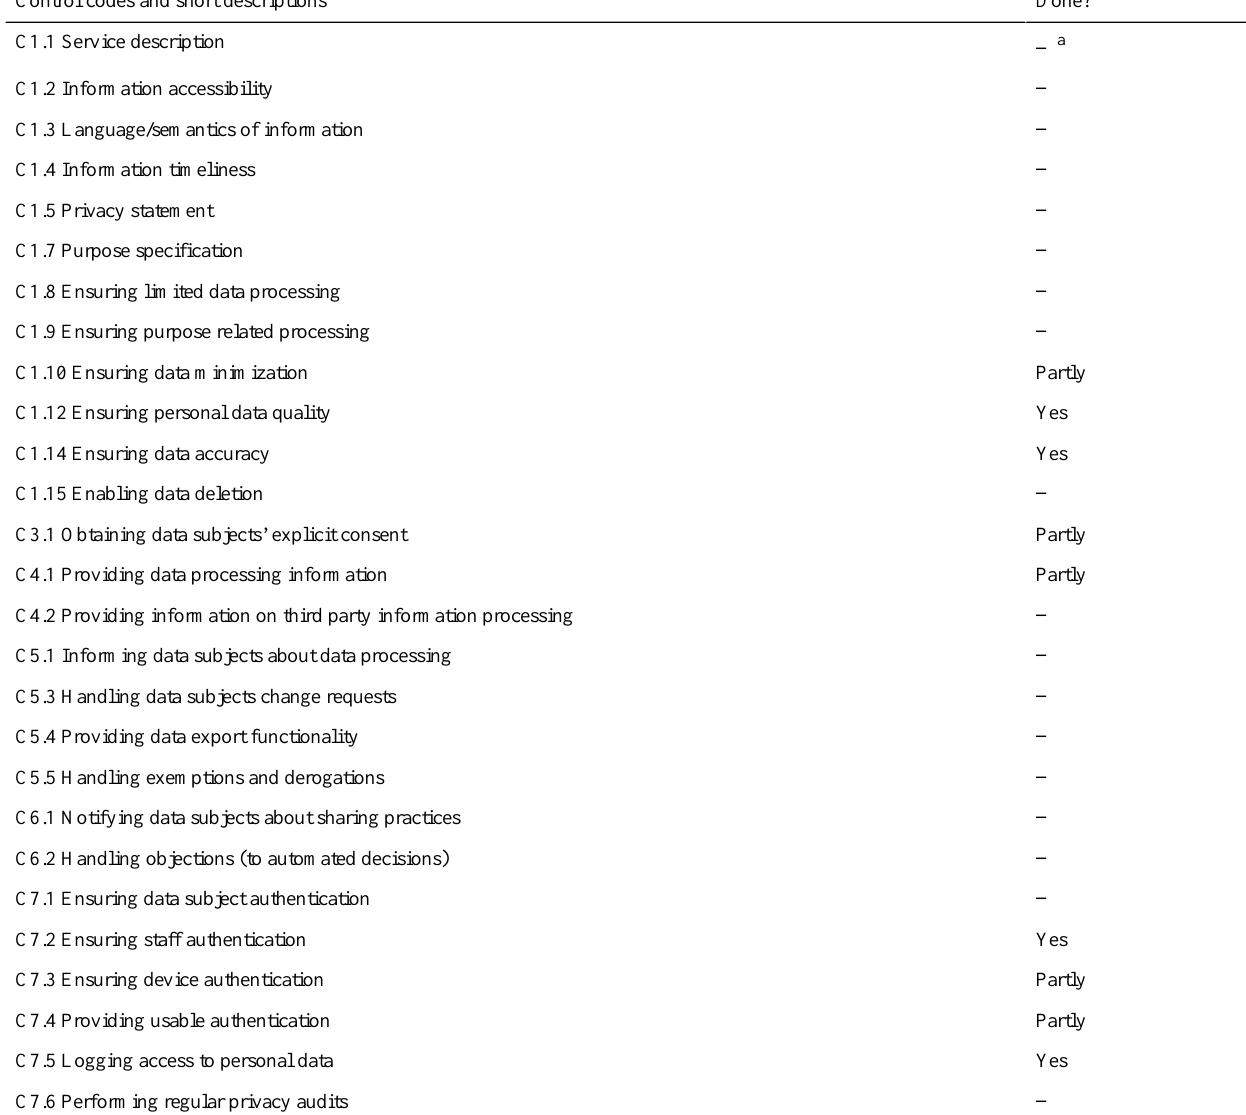
Table 1. Consolidated list of controls. The detailed description of all controls can be found in Multimedia Appendix